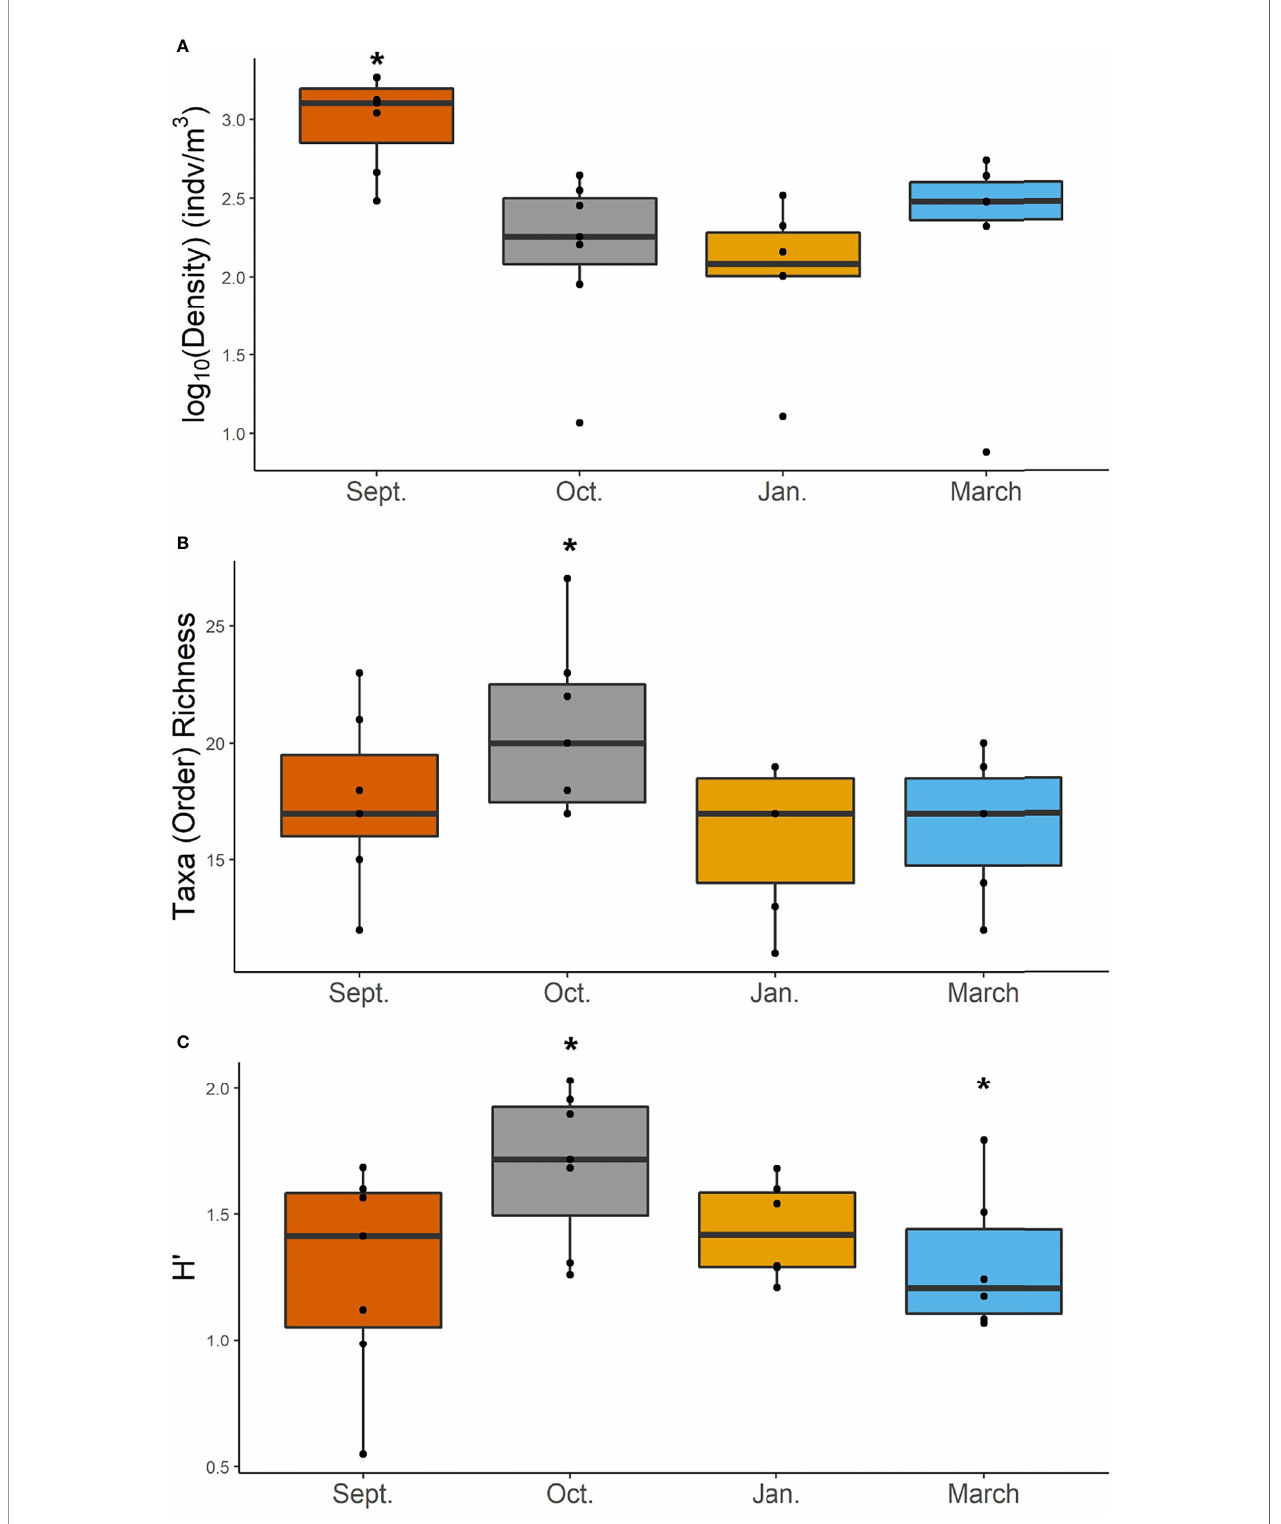
FIGURE 2 | Density (log10 transformed) (A) , taxa richness at order (B) , and Shannon-Weiner diversity (H ′ ) (C) of mesozooplankton for each cruise. Asterisk denotes groups that are signi fi cantly different based on a two-way ANOVA and post-hoc Tukey test. Differences in abundance were determined using a Kruskal – Wallis and pairwise-Wilcox